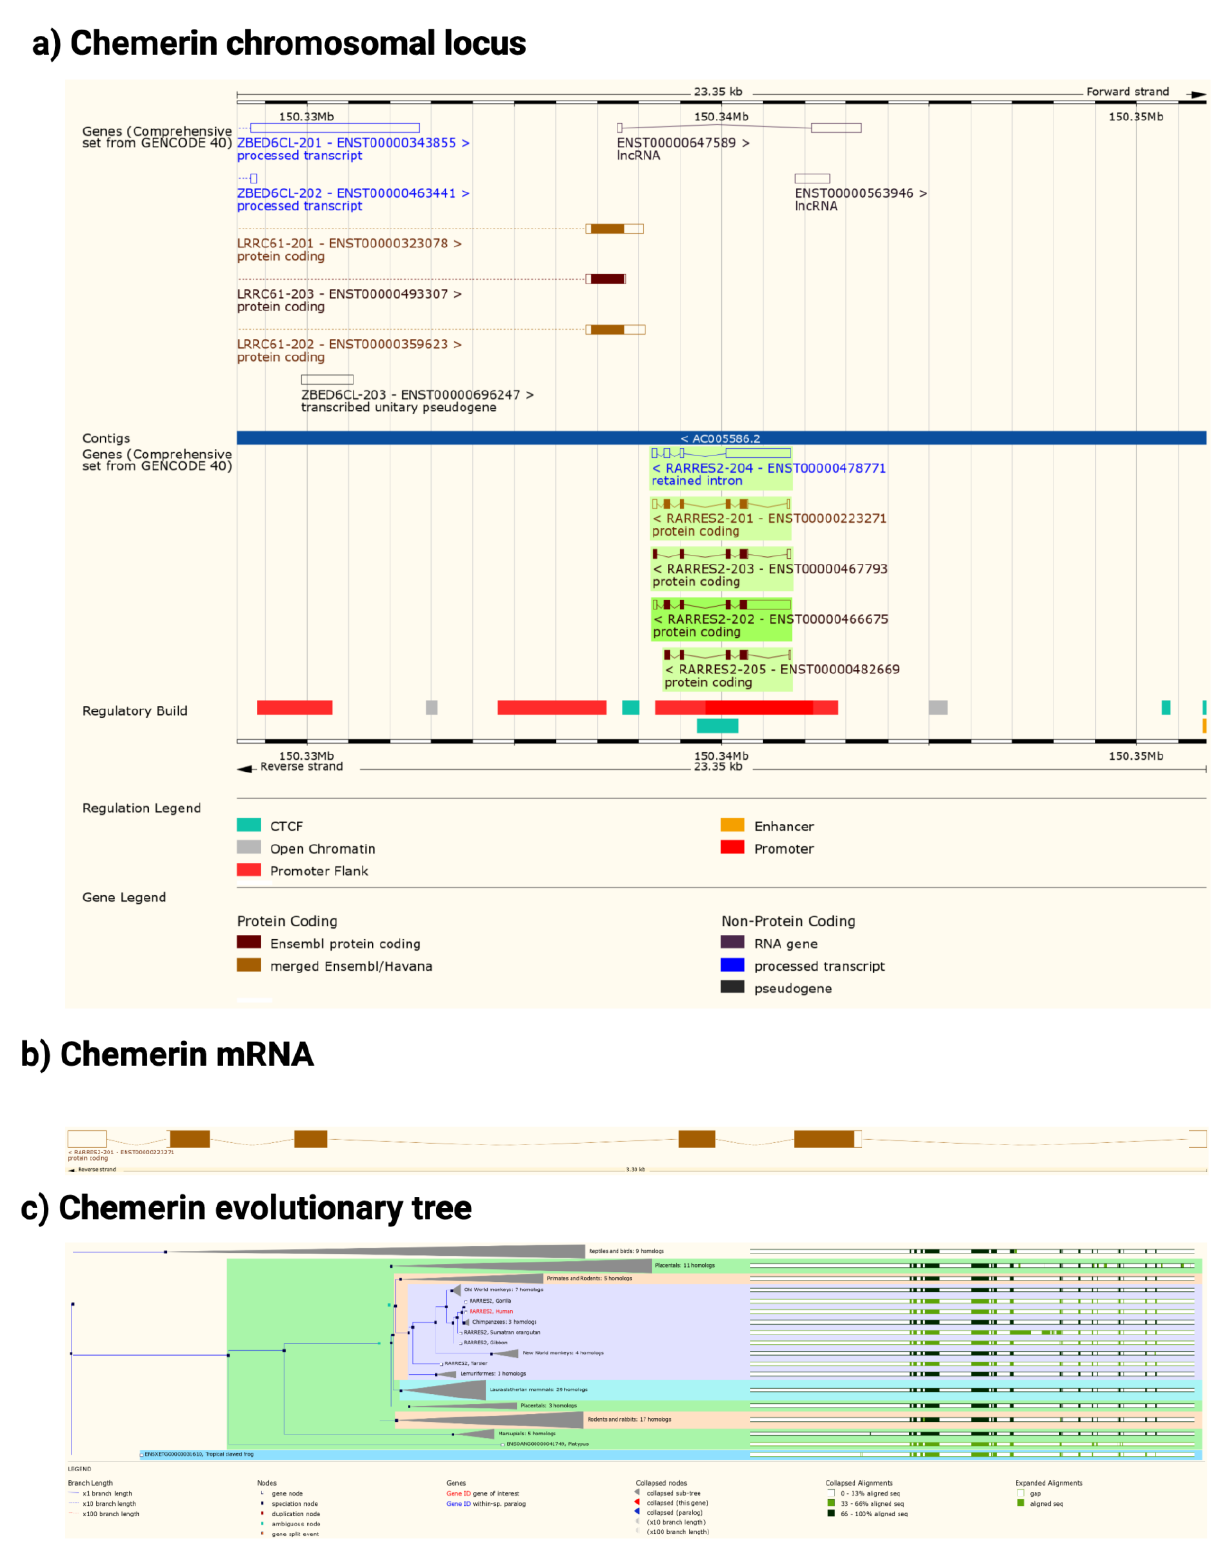
Figure 2. Chemerin gene ( Rarres2 ), mRNA, and evolutionary tree. ( a ) Chromosomal neighborhood